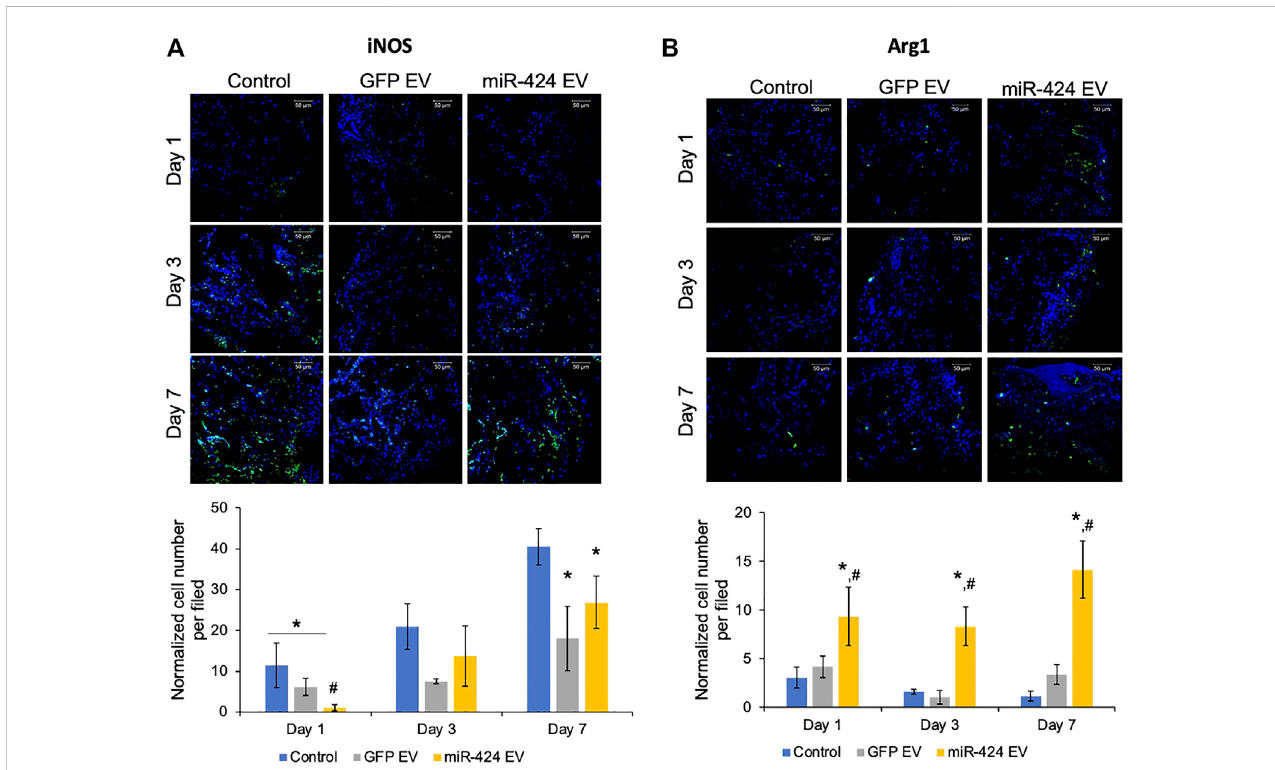
FIGURE 6 In vivo Immunomodulatory properties of the engineered EVs. (A) Representative confocal micrographs of calvarial wound beds at days 1, 3 and 7 post wounding immunostained for iNOS in fl ammatory macrophage marker (green) and counter stained with DAPI nuclear stain (blue) followed (below) by quantitation of average number of cells expressing iNOS per fi eld of view. Note the signi fi cant reduction in iNOS expressing cells at days 1 and 7 in the EV treated groups and the signi fi cant reduction in 424 EV group compared to both control and control EV groups at day 1. (B) Representative confocal micrographs of calvarial wound beds at days 1, 3 and 7 post wounding immunostained for Arg1 reparative macrophage marker (green) and counter stained with DAPI nuclear stain (blue) followed (below) by quantitation of average number of cells expressing Arg1 per fi eld of view. Note the signi fi cant increase in Arg1 expressing cells at days 1, 3 and 7 in the 424 EV treated group compared to both control and control EV groups. * in both graphs represents signi fi cance with respect to control and # represents signi fi cance with respect to control EV group measured by Tukey ’ s test post